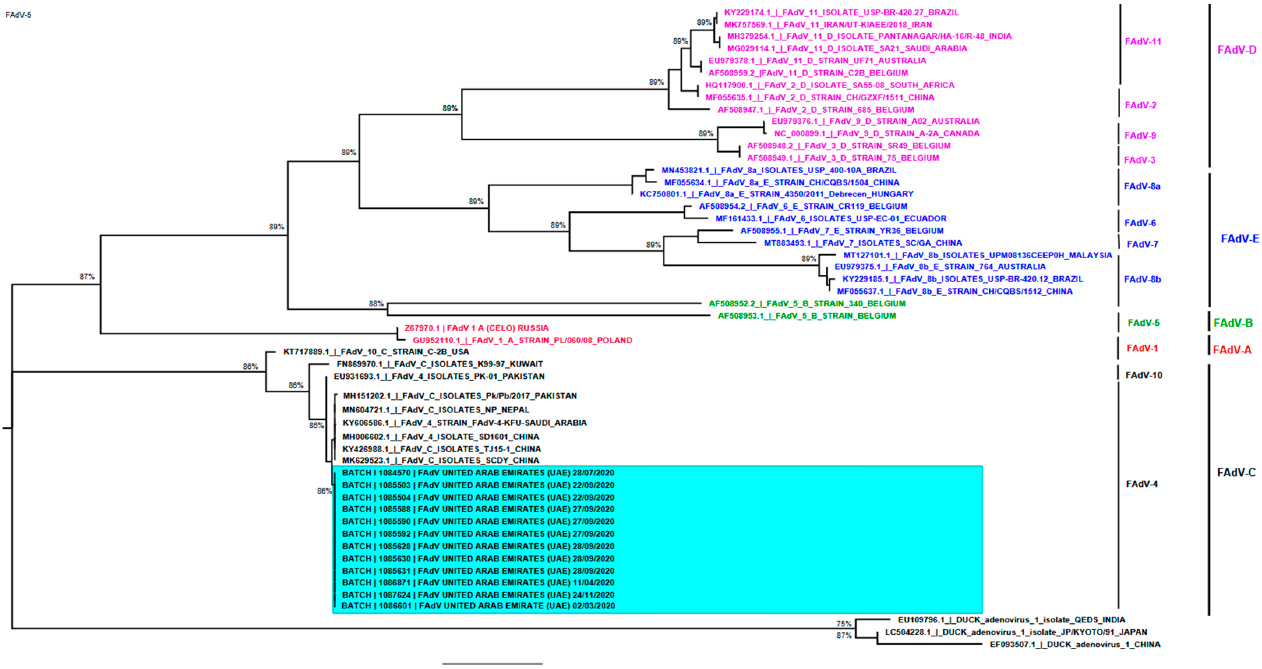
Figure 7. Hexon gene-based phylogenetic analysis of FAdV serotype 4. The tree was constructed using MEGA X software by the Maximum Likelihood method (1000 replicates for bootstrap utilizing the partial FAdV serotype 4 hexon gene obtained from sequencing of twelve FAdV field strains from UAE strain and other forty-one representatives FAdV reference strains obtained from GenBank. The UAE FAdVs are clustered into FAdV serotype 4, species C, with other isolates from Saudi Arabia, Pakistan, Nepal and China. The FAdV serotype 4, species C of UAE field strains, was highlighted. Serotypes are indicated on the right.